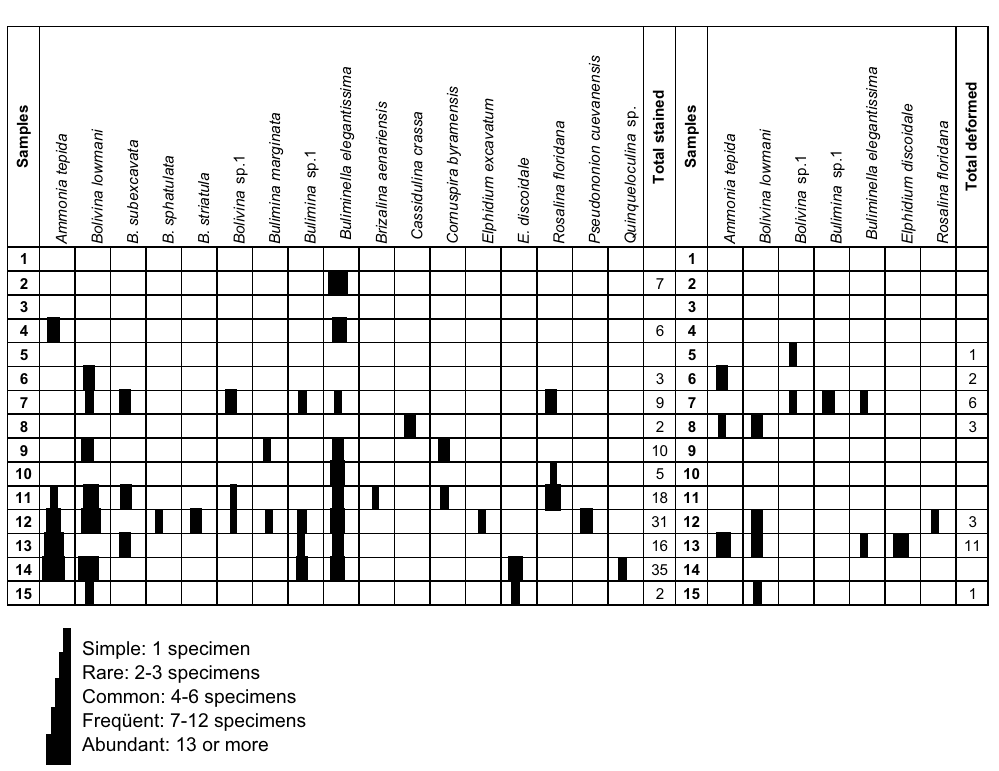
Fig. 6 – Frequence of stained and deformed foraminiferal tests in samples from Niterói, Guanabara